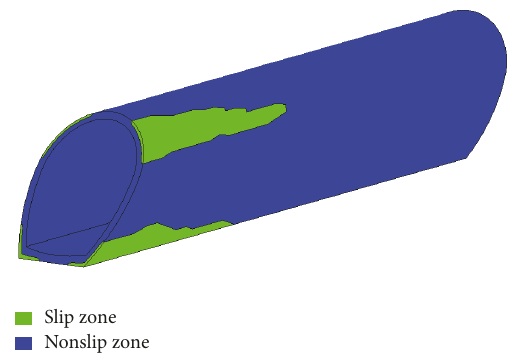
Figure 13: Slip zone distribution of lining after the